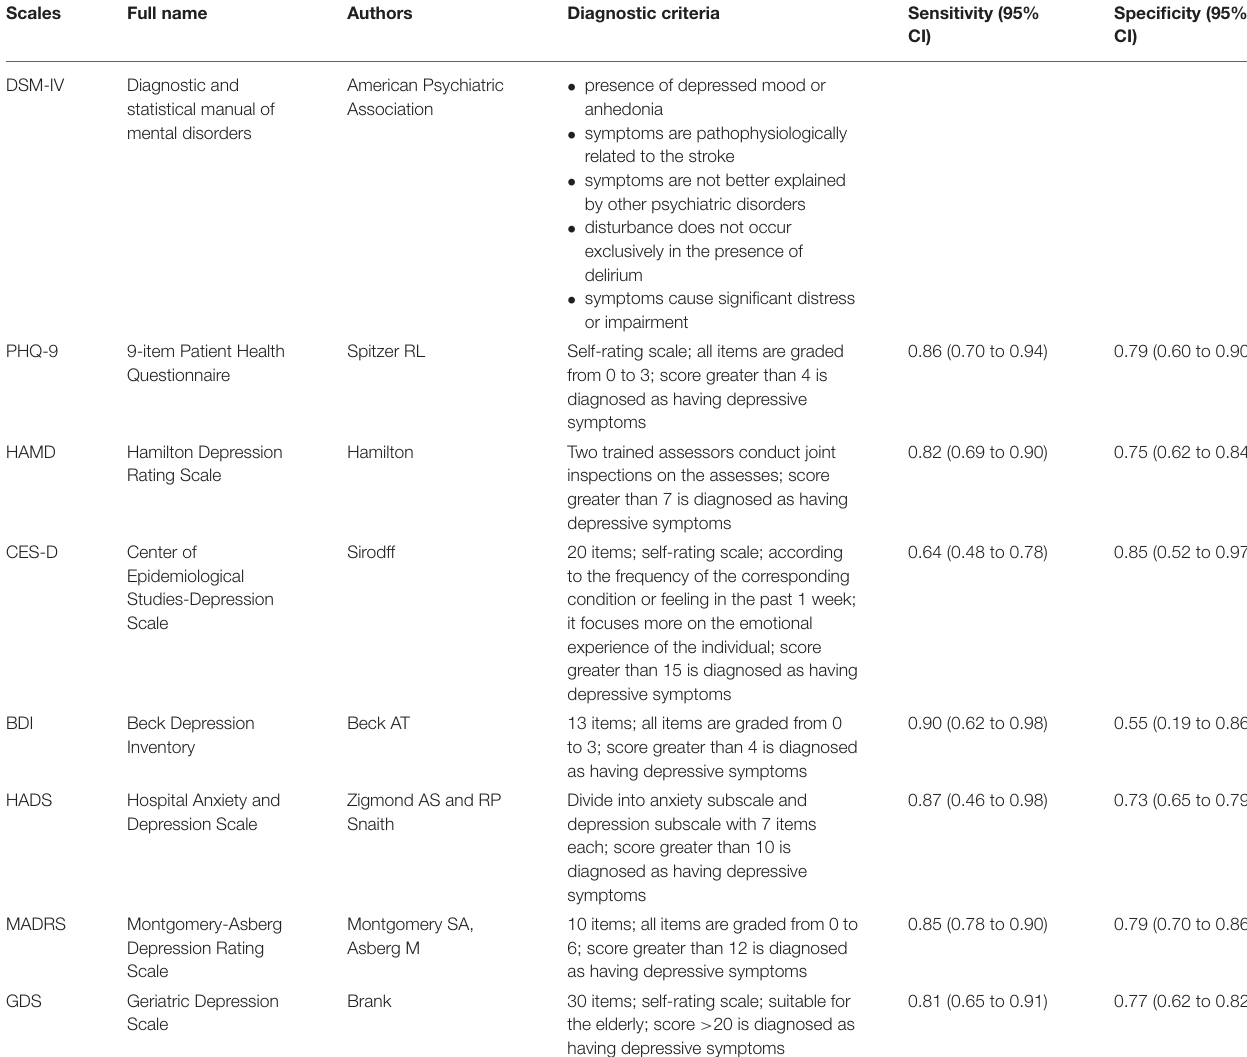
TABLE 1 | Main tools to screen and diagnose the PSD.